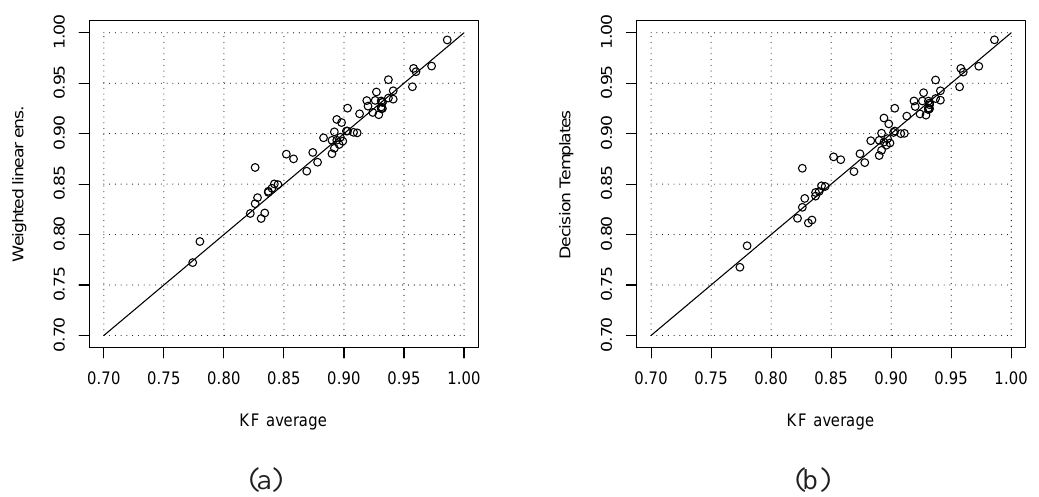
Figure 1: Comparison of AUC results between average kernel fusion and ensemble data integra- tion methods without noisy data. Points represent the AUC score of kernel fusion (abscissa) and ensemble (ordinate) methods for 56 GO terms. (a) Average KF vs Weighted ensembles (b) Average KF vs Decision Templates.